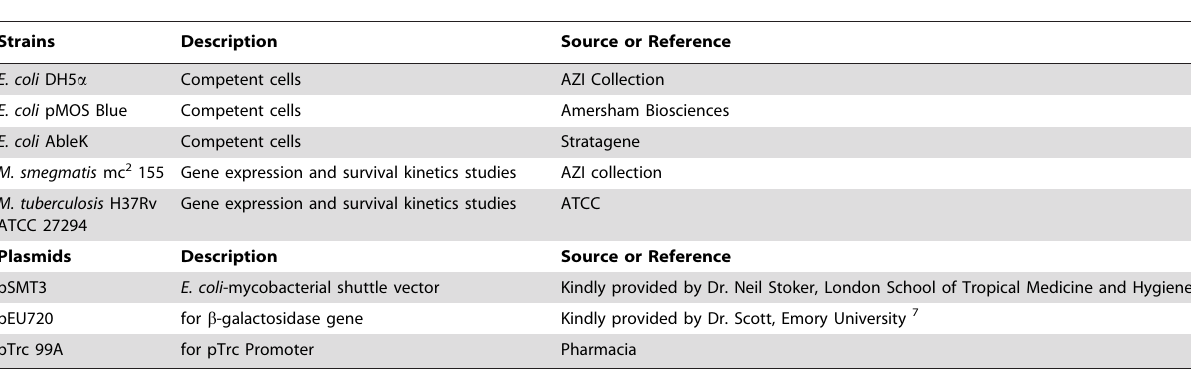
Table 2. Bacterial strains and plasmids used in this